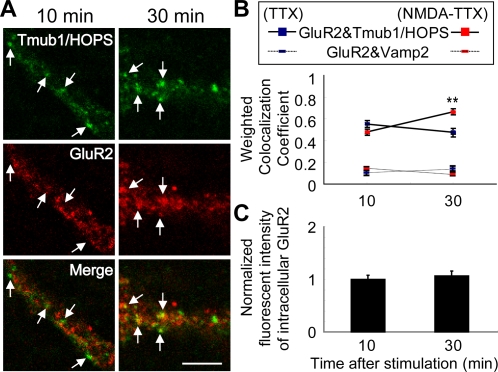
A large portion of Tmub1/HOPS colocalizes with GluR2 at recycling endosomes.After 1 h of preincubation with TTX, neurons were incubated with extracellularly binding anti-GluR2 antibody, stimulated with NMDA/TTX for 3 min, and further incubated for 10 or 30 min. Then, the cells were acid washed to remove extracellular labeling, fixed, and colabeled with Tmub1/HOPS or the synaptic vesicle protein VAMP2. (A) Tmub1/HOPS (green) and GluR2 (red) and their merged images (yellow) are shown. Many of Tmub1/HOPS-positive dots (arrows in the left image) were not colocalized with GluR2 at 10 min after NMDA stimulation, while many of the them (arrows in the right image) were colocalized with GluR2 at 30 min after the stimulation. Scale bar, 10 µm. (B) The weighted colocalization coefficient between GluR2 and Tmub1/HOPS (square) or VAMP2 (rectangle) is shown. Blue color presents control cells for TTX incubation, while red color presents cells for NMDA/TTX incubation. The weighted colocalization coefficient between GluR2 and Tmub1/HOPS in NMDA/TTX incubation was significantly increased at 30 min compared with at 10 min (n = 14 ; **P<0.01; t-test), while its coefficient in TTX incubation or the coefficient between GluR2 and VAMP2 in TTX or NMDA/TTX incubation did not show significant changes. (C) Normalized fluorescent intensities of intracellular GluR2 at incubation time of 10 min or 30 min are shown. The fluorescent intensity of intracellular GluR2 at 10 min was used for normalization. There was no significant change between the intensity of 10 min and the intensity of 30 min. The values shown indicate the means±SEM.